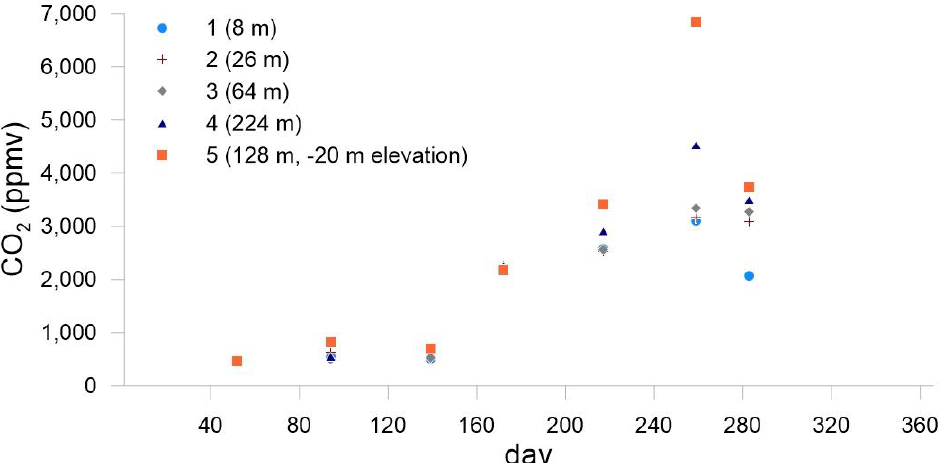
Figure 9. Spot air CO 2 concentrations data, measured inside Santa Ninfa cave in the period 2000–2007. Time is expressed as the ordinal of the day of the year of acquisition of each measure. Progressive distances of the points from cave entrance are reported between round brackets (see also Figure 3 for point locations).